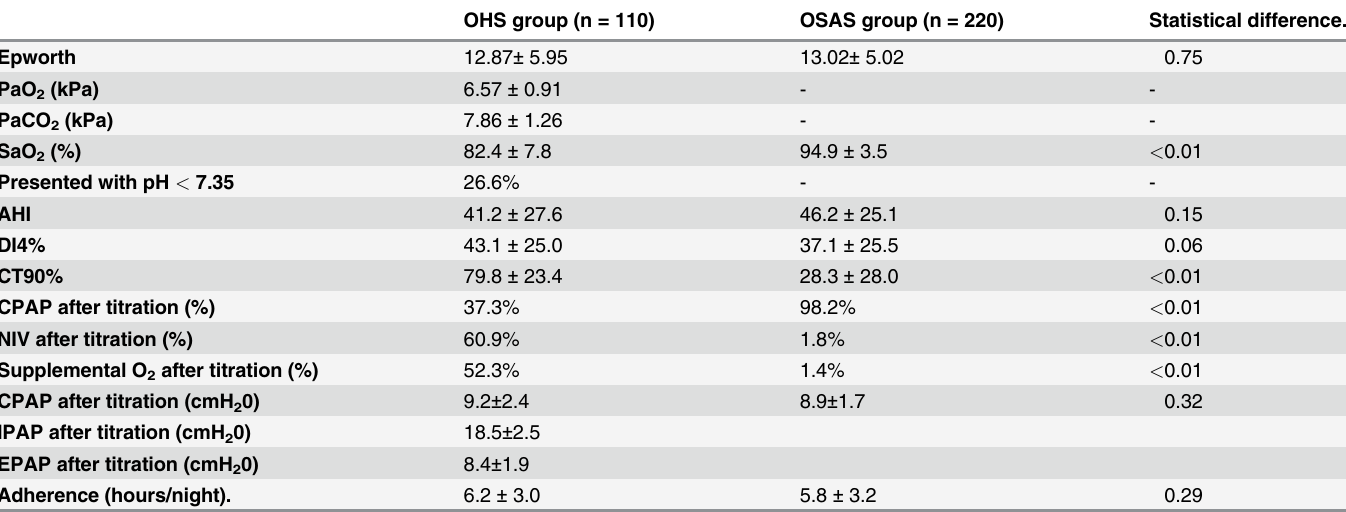
Table 2. Epworth sleepiness scale, basal arterial blood gas results, sleep study fi ndings and therapeutic intervention for the 2 cohorts.